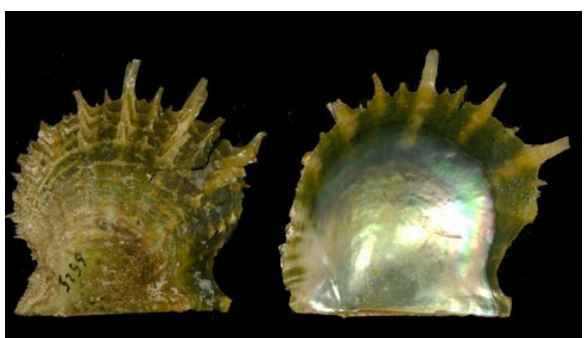
Figure 19. Images of the shell of Pinctada imbricata . © Natural History Museum Rotterdam (CC BY-NC-SA 4.0); http://www.marinespecies.org/.